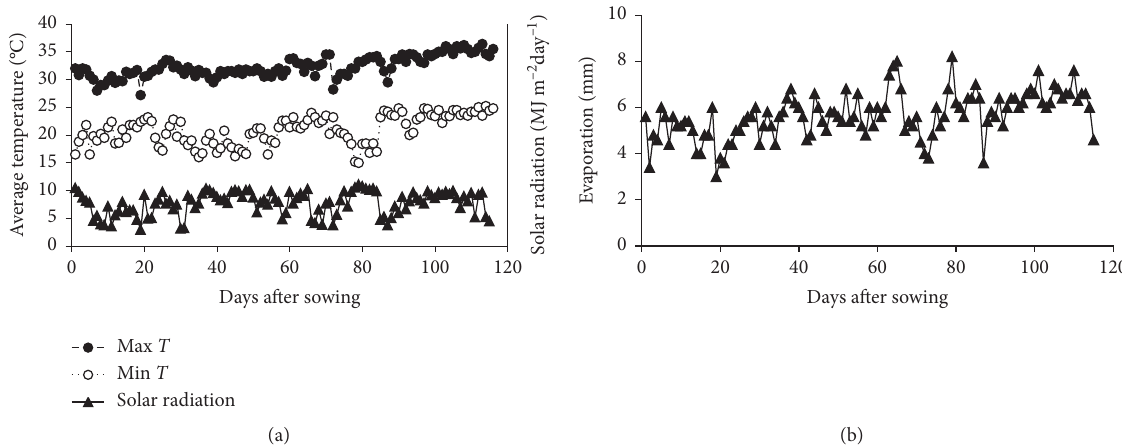
Figure 2: Daily maximum, minimum temperature, solar radiation (a), and evaporation rate (b) prevailed during the experiment (summer,